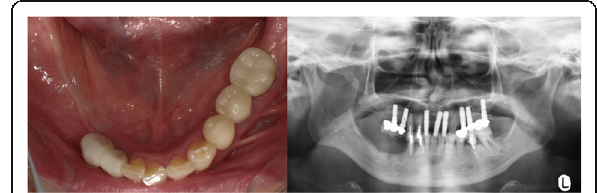
Fig. 6 Postoperative intraoral finding and